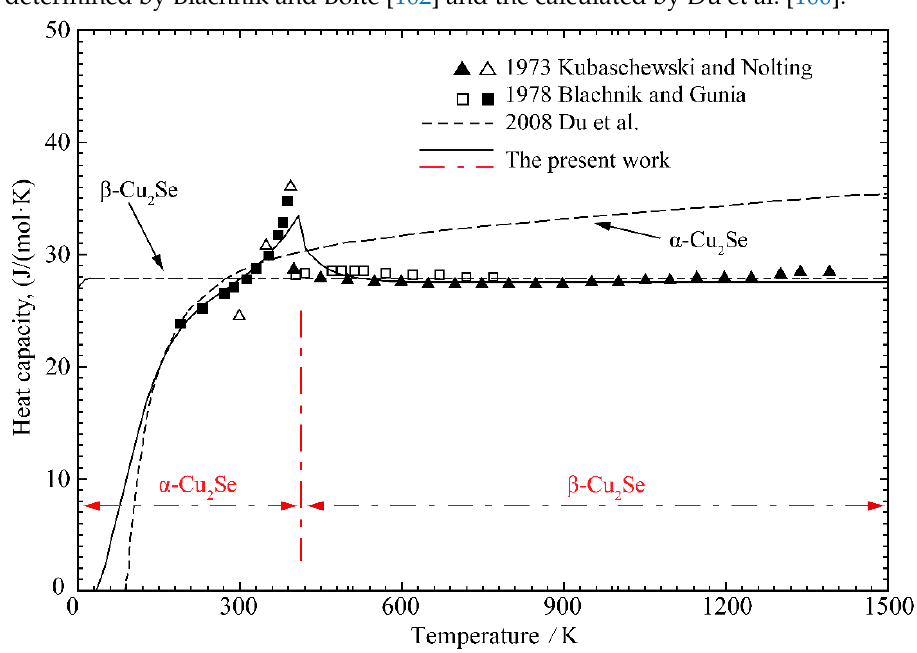
Figure 12. The calculated heat capacities of Cu 2 Se in the Cu-Se system compared with the experi- mental data from refs. [97,98] and previously optimized results by Du et al. [100].